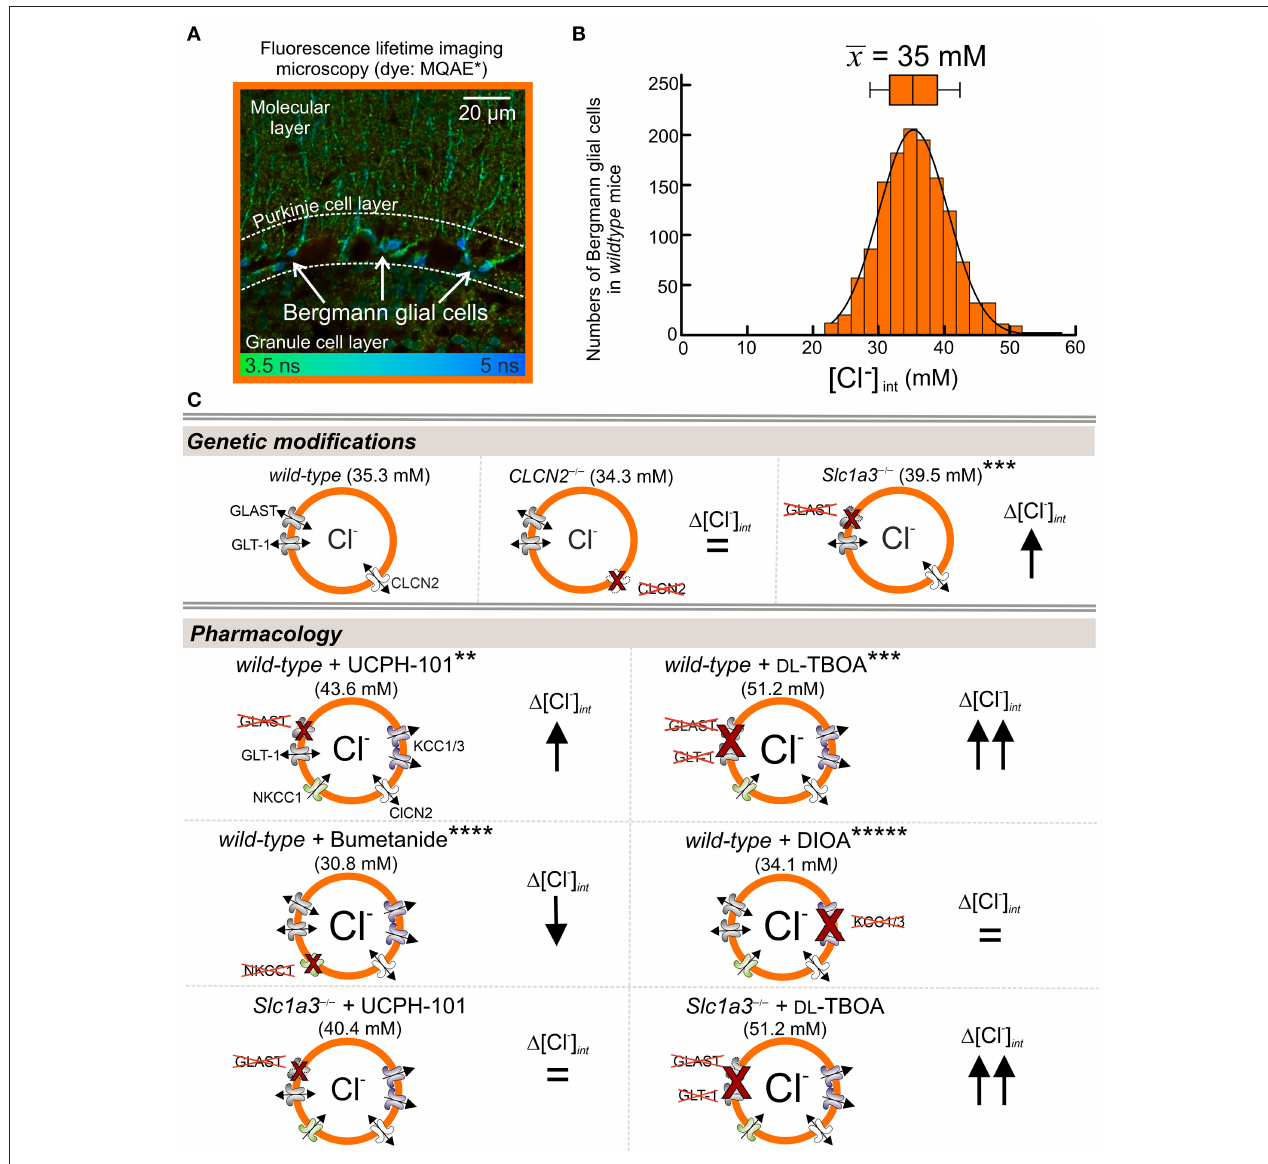
FIGURE 2 | EAAT1/GLAST contributes to [Cl − ] int in Bergmann glial cells. (A,B) Fluorescence lifetime imaging with the Cl − -sensitive dye MQAE. (A) Representative FLIM images from acute sagittal slices of the cerebellar cortex show MQAE-stained Bergmann glial cells (BGLs, arrows) in the Purkinje cell layer. (B) Distribution of [Cl − ] int from BGLs, with a mean ( ± SD) of 35.3 ± 6.3mM. (C) [Cl − ] int is higher in GLAST-knockout ( Slc1a3 − / − ) than in wild-type (WT) BGLs, but is not affected by genetic ablation of CLCN2 (chloride voltage-gated channel 2). [Cl − ] int increases upon pharmacological blockage by the EAAT1-specific inhibitor UCPH-101 and the EAAT-specific blocker DL -TBOA. Reduction of Cl − import by the NKCC1-specific inhibitor bumetanide decreases [Cl − ] int , whereas inhibition of glial Cl − -exporters KCC1 and KCC3 by DIOA has no effect on [Cl − ] int . Control experiments with Slc1a3 − / − mice showed, that GLT-1 also contributes to chloride homeostasis (lower panel). Modified and reprinted from Untiet et al. (2017), with permission. *MQAE: 6-(Methoxychinolinio)acetic acid ethyl ester bromide (C 14 H 16 BrNO 3 ). **UCPH-101: 2-Amino-4-(4-methoxyphenyl)-7-(1-naphthyl)-5-oxo-5,6,7,8-tetrahydro-4H-chromene-3-carbonitrile